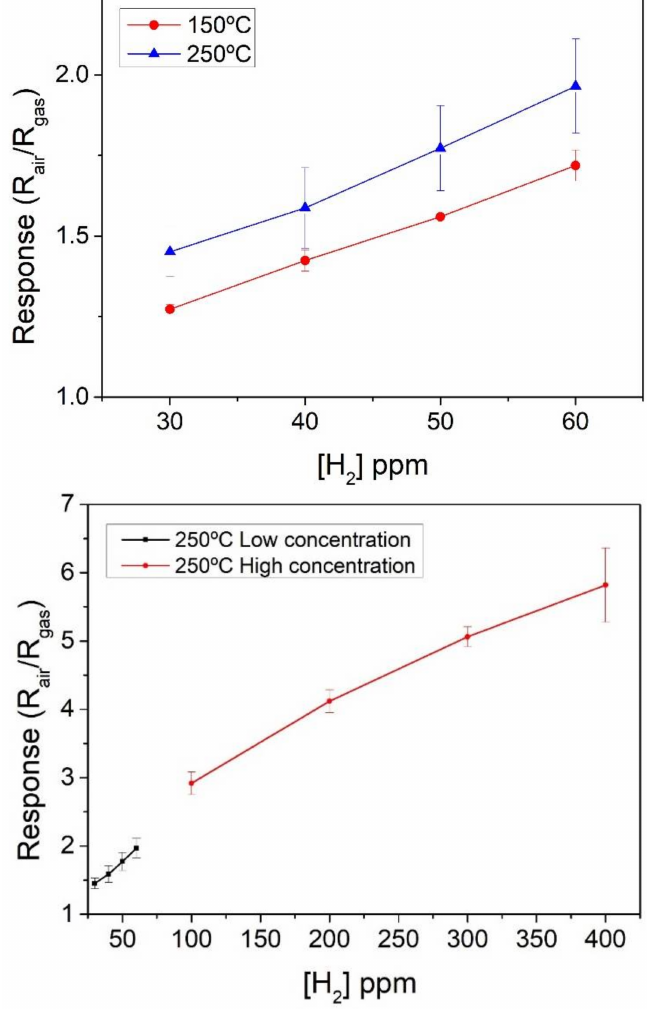
Figure 6. Effect of the operating temperature on the response towards different concentrations of H 2 ( upper panel ). Calibration curve towards hydrogen for a sensor operated at the maximum allowed working temperature of 250 ◦ C, which resulted in the higher responsiveness to hydrogen ( lower panel